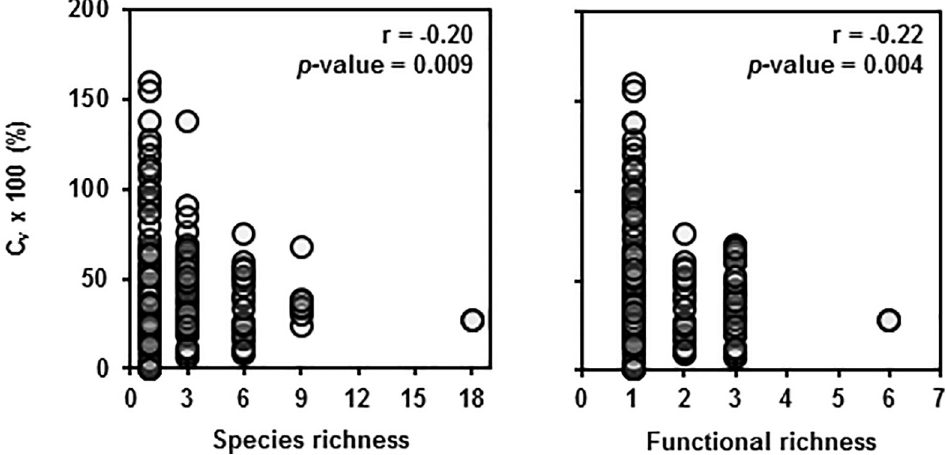
Fig 7. Effect of diversity measures on cover crop biomass coefficient of variation. Coefficient of variation of aboveground cover crop biomass across treatments and study sites plotted against realized species (left) and functional (right) richness. Pearson correlation coefficients (r) given with p -values for the following test—H 0 : r = 0; H a : r 6¼